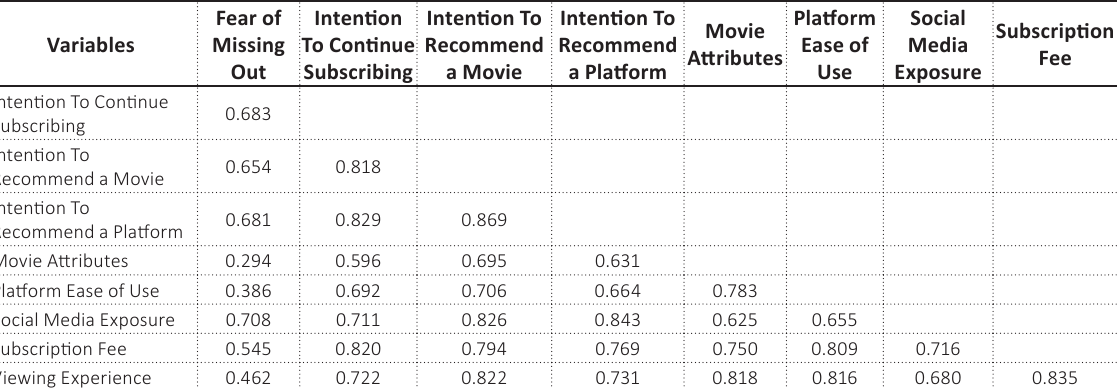
Table 3. Discriminant validity